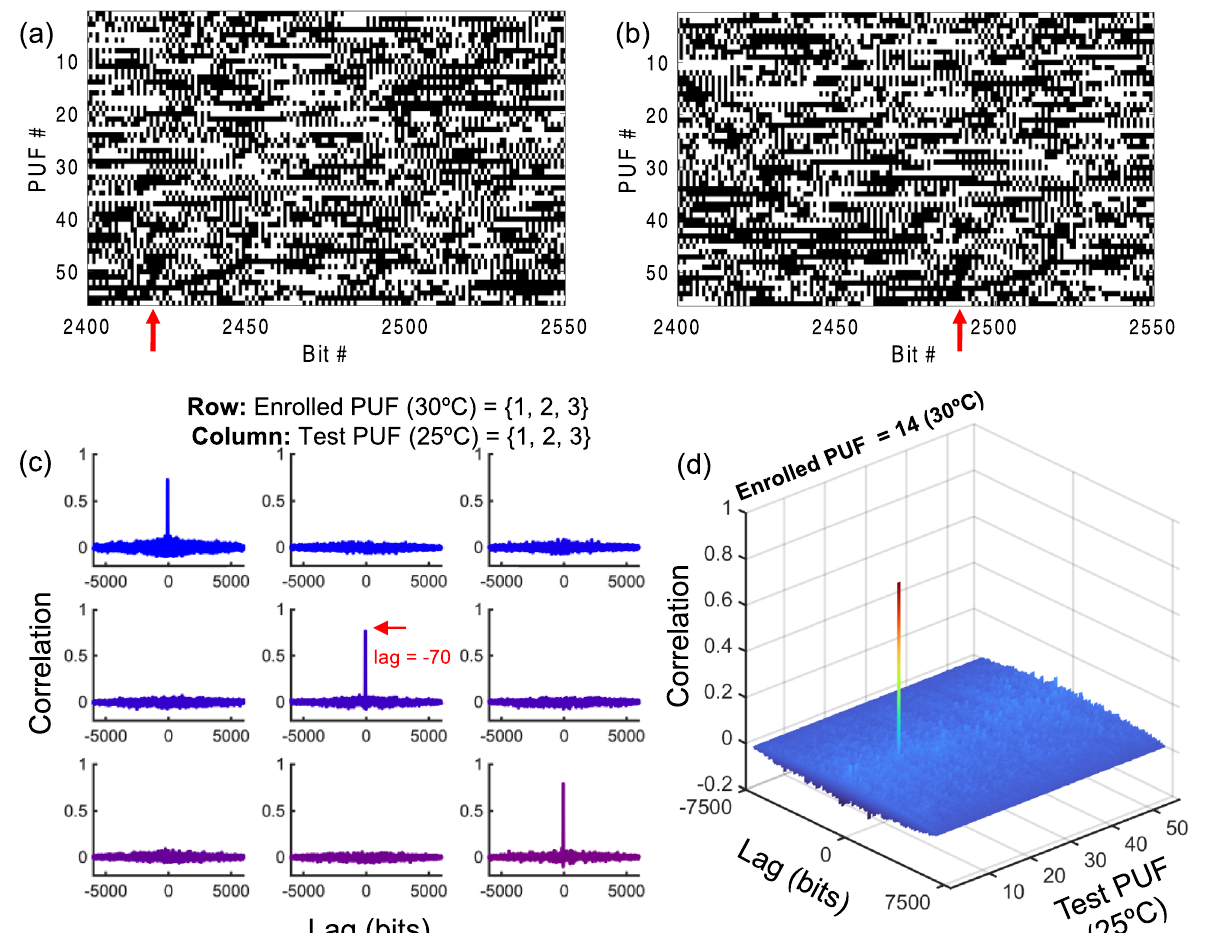
Figure 2. Digital keys and cross-correlation analysis. Visualization of a 150 bit subset of the binary keys generated from all 56 PUFs extracted from measurements at ( a ) 25 °C and ( b ) 30 °C; the red arrow indicates the 70 bit lag observed due to the spectral shift over temperature. ( c ) Cross-correlation analysis depicting the normalized correlation coefficient between the enrolled PUF at 30 °C and test PUF at 25 °C versus lag for selected PUFs 1–3. ( d ) Example cross-correlation analysis of enrolled PUF 14 versus all 56 test PUFs verifying the uniqueness and authenticity of the enrolled